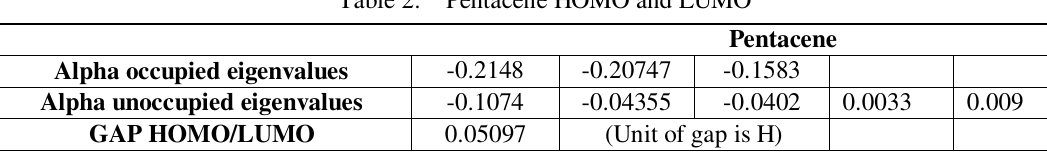
Table 2: Pentacene HOMO and LUMO